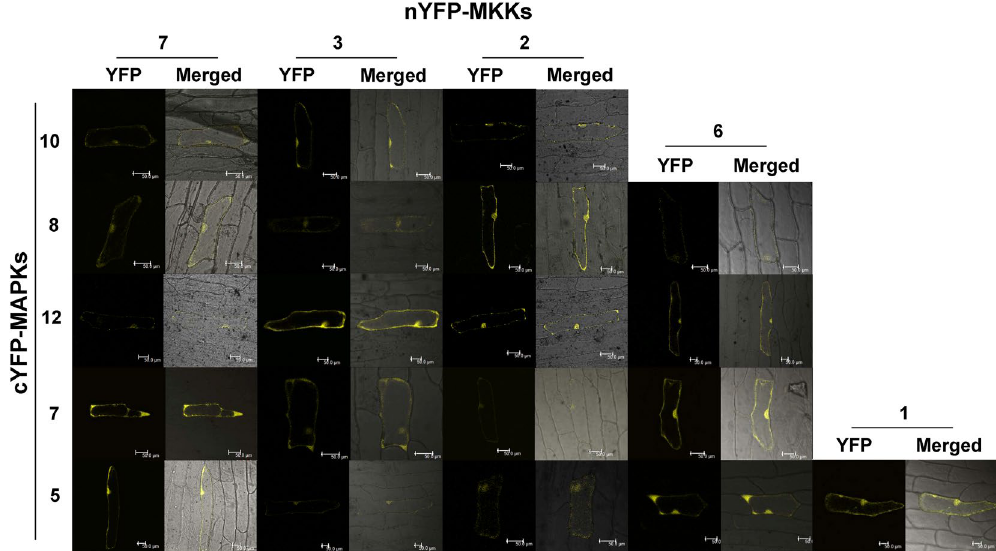
Figure 4. BiFC assay to verify the MKK-MAPK interactions identified by Y2H. Chickpea MKKs were tagged with N-terminal half of YFP and MAPKs were tagged with C-terminal half of YFP. Plasmid DNA of MKK and MAPK clone was precipitated on gold particles and bombarded on onion epidermal cells. Cells were observed for YFP fluorescence under a confocal microscope after 48 hours. YFP and merged (bright field and YFP) photographs are presented here for 20 interaction pairs of chickpea MKK-MAPK. BiFC assay negative controls (not shown here) were also checked. Scale bars, 50 µ